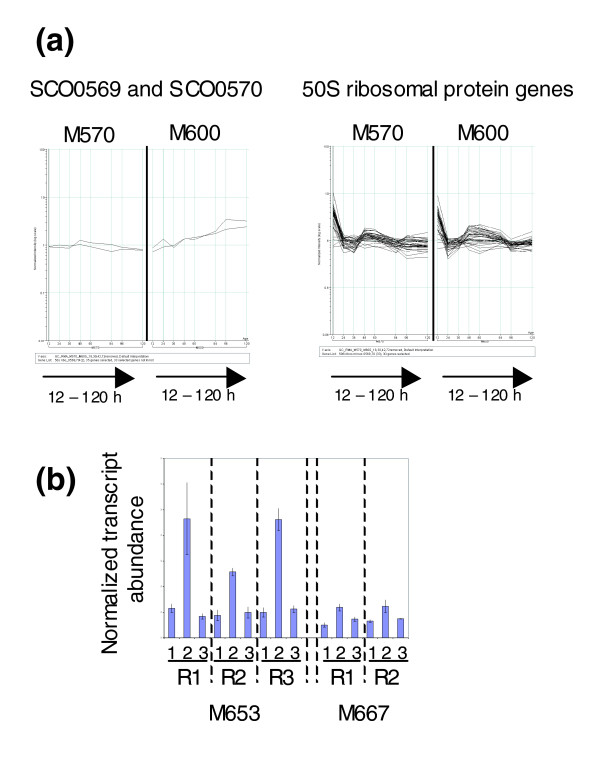
ppGpp synthesis and the expression of alternative ribosomal protein genes.(a) Different growth-phase dependent expression of genes encoding the alternative ribosomal proteins SCO0569 and SCO0570 compared to the 50S ribosomal protein genes. In each panel, the x-axis represents culture age, and the y-axis is normalized transcript abundance in log10 scale. (b) qRT-PCR shows transcription of SCO0570 is activated following induction of ppGpp synthesis. In each biological replicate experiment, R1-R3, using strain M653 [ΔrelA tipAp::relA(1.46 kb)] or the control strain M667 [ΔrelA tipAp], lane 1 corresponds to the pre-induction sample (0 minutes), and lanes 2 and 3 correspond to the samples taken 60 minutes after induction or non-induction with thiostrepton, respectively. The average of three qRT-PCR determinations is shown, and standard deviations are marked with error bars.